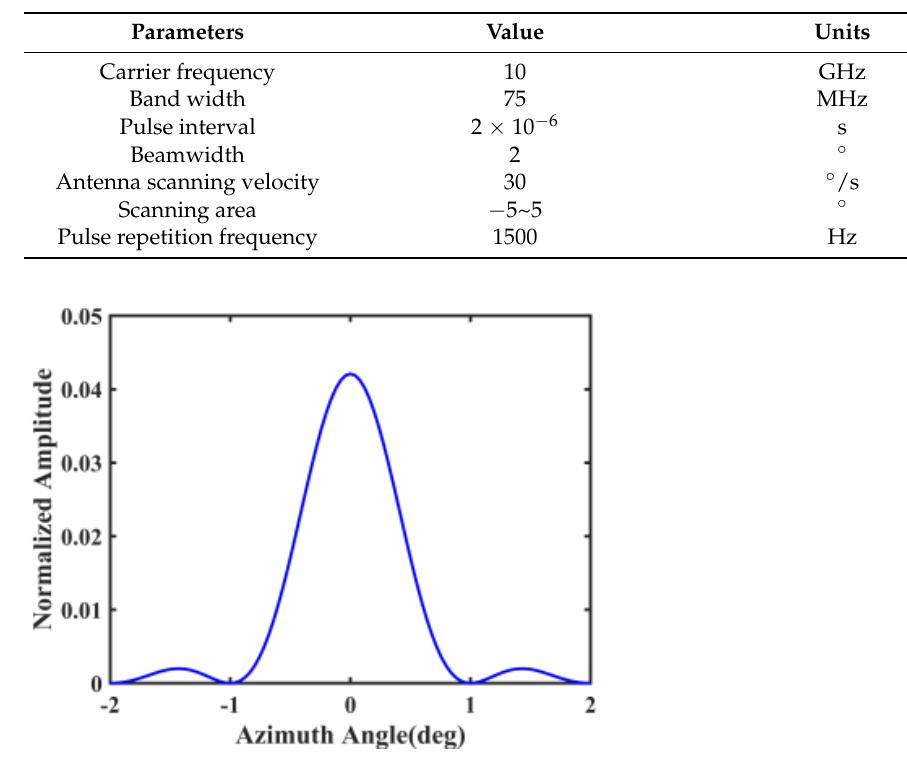
Table 2. Mean PSNR (dB), SSIM and SSE results with 500 simulations.